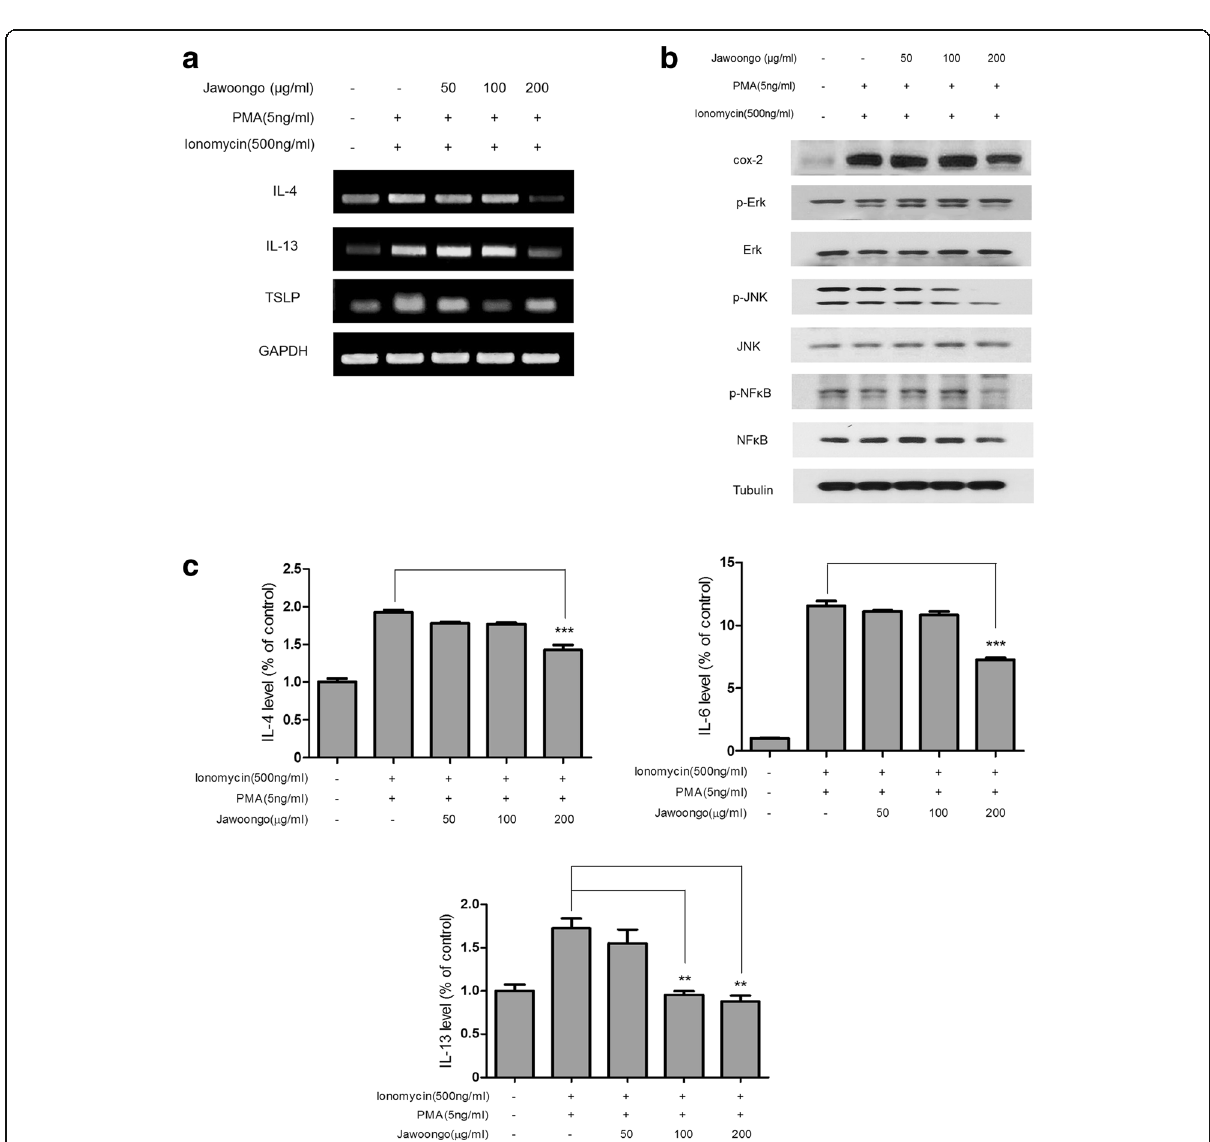
Fig. 7 Effects of Jawoongo on cytokine expression in HMC-1 cells. HMC-1 cells were stimulated with ionomycin (500 ng/ml) and PMA (5 ng/ml) and then treated with different concentrations of Jawoongo (50 – 200 μ g/ml) for 24 h. IL-4, IL-13 and TSLP mRNA expression was measured by RT-PCR ( a ). Whole cell lysates were analyzed by Western blotting ( b ). The culture medium of the cells was harvested, and IL-4, IL-6 and IL-13 cytokine levels were measured by ELISA ( c ). The data were presented as mean ± SEMs ( n = 8 mice/group). * P < 0.05, ** P < 0.01 and *** P < 0.001 as compared to Ionomycin and PMA-stimulated group,